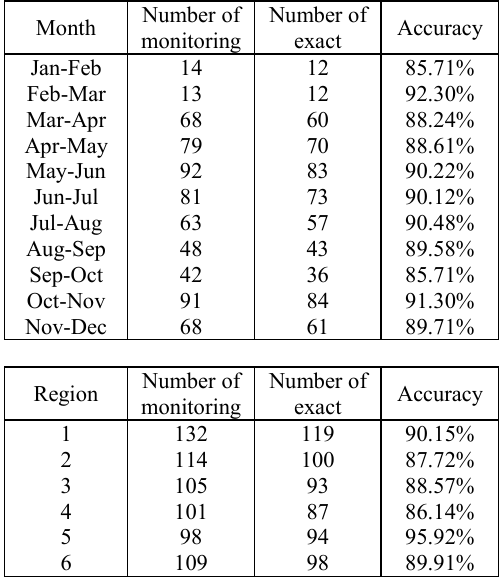
Table3. The accuracy of suspected arable land cover change of different months and different cities during 2021